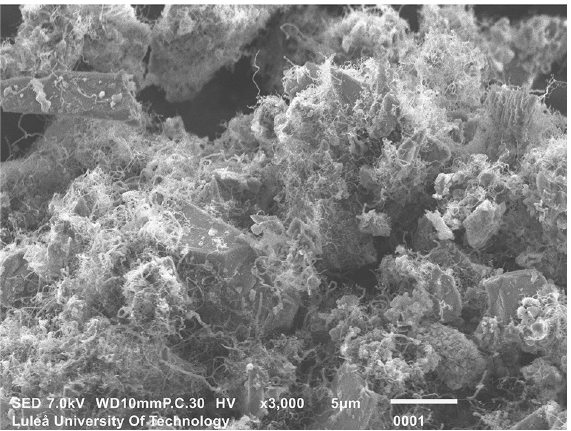
Figure 1. Scanning Electron Microscope image of the nanomodified cement. This figure was taken using InTouchScope software version JSM-IT100 (https:// www. jeol. co. jp/ en/ produ cts/ detail/ JSM- IT100.